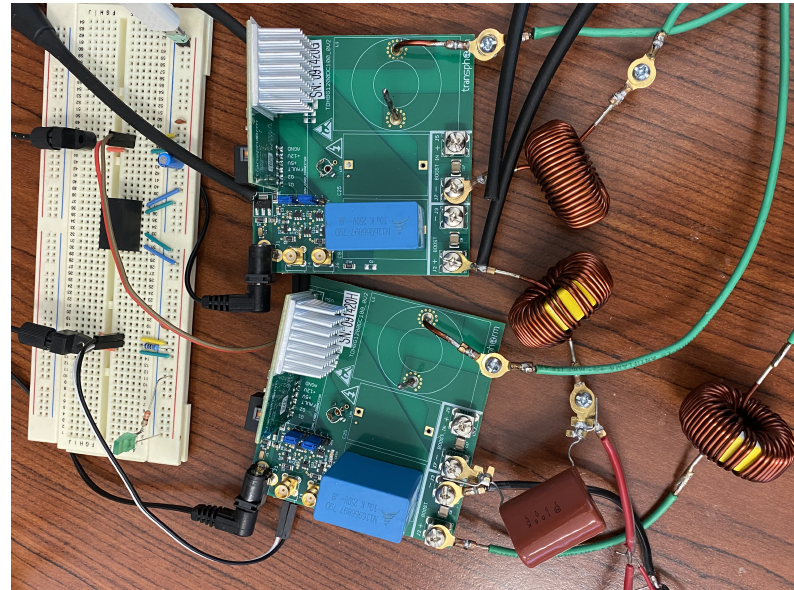
Figure 12. Prototype